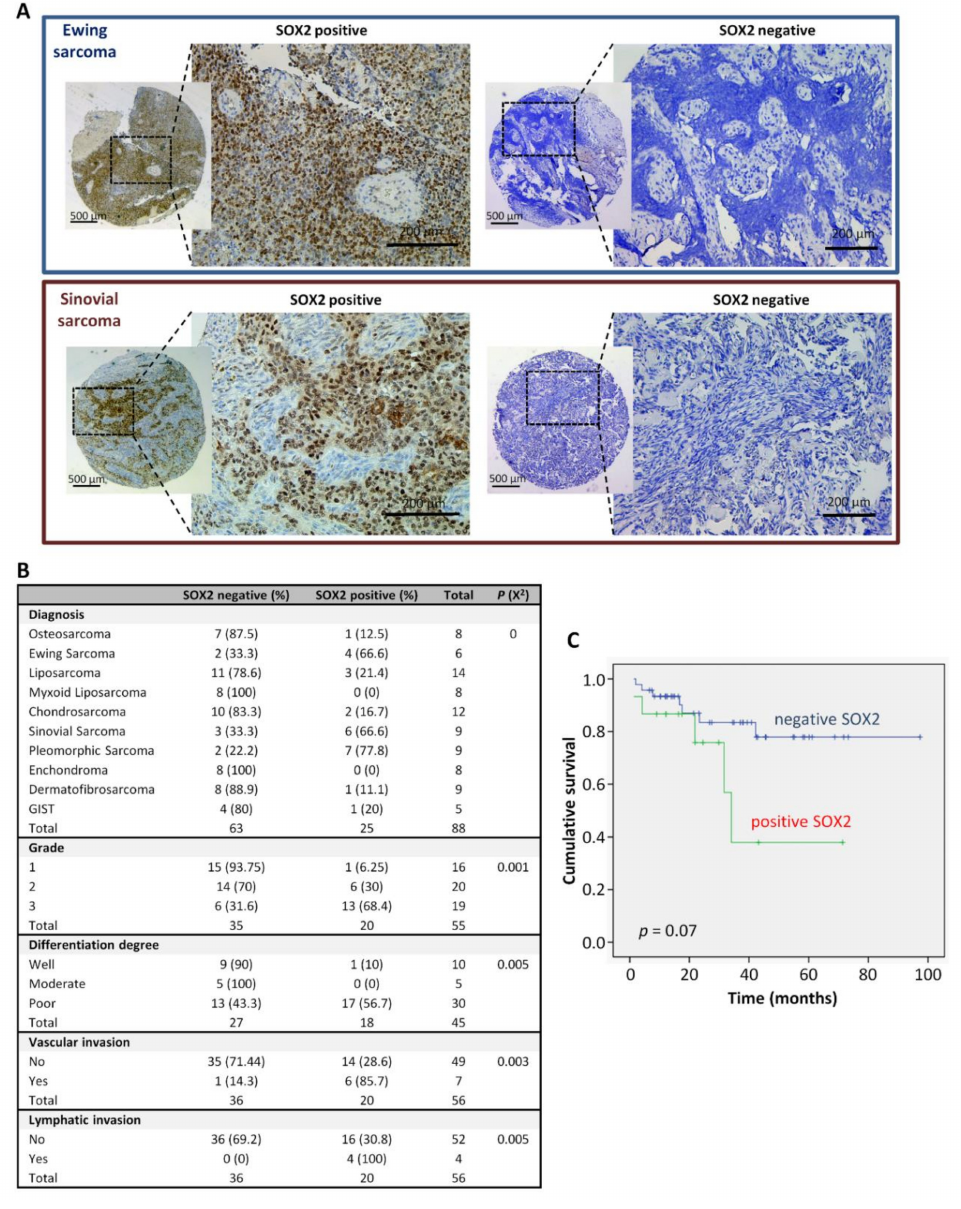
Figure 1. Immunohistochemical analysis of SOX2 expression in sarcoma patients and associations with clinical data. ( A ) Representative examples of the indicated types of sarcoma showing positive or negative SOX2 staining. Scale bars: 200 or 500 µ m (insets). ( B ) Distribution of sarcoma cases (N = 88) according to their SOX2 expression level across categories of the indicated patient characteristics and tumor clinicopathologic parameters. p values are shown. ( C ) Kaplan-Meier cumulative survival curves categorized by SOX2 protein expression in the cohort of sarcoma patients. p -values were estimated using the log-rank